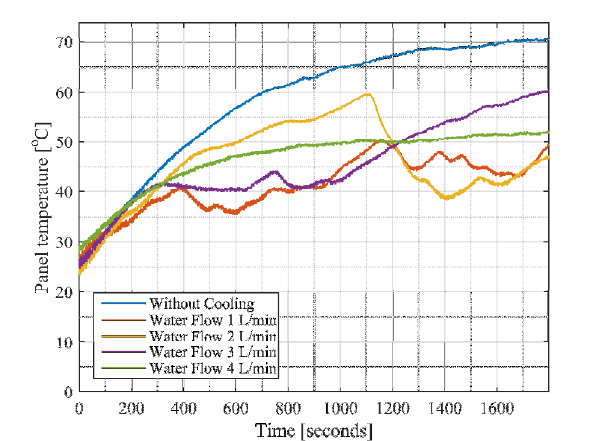
Fig. 5. Effect of water flow rate in the panel temperature.